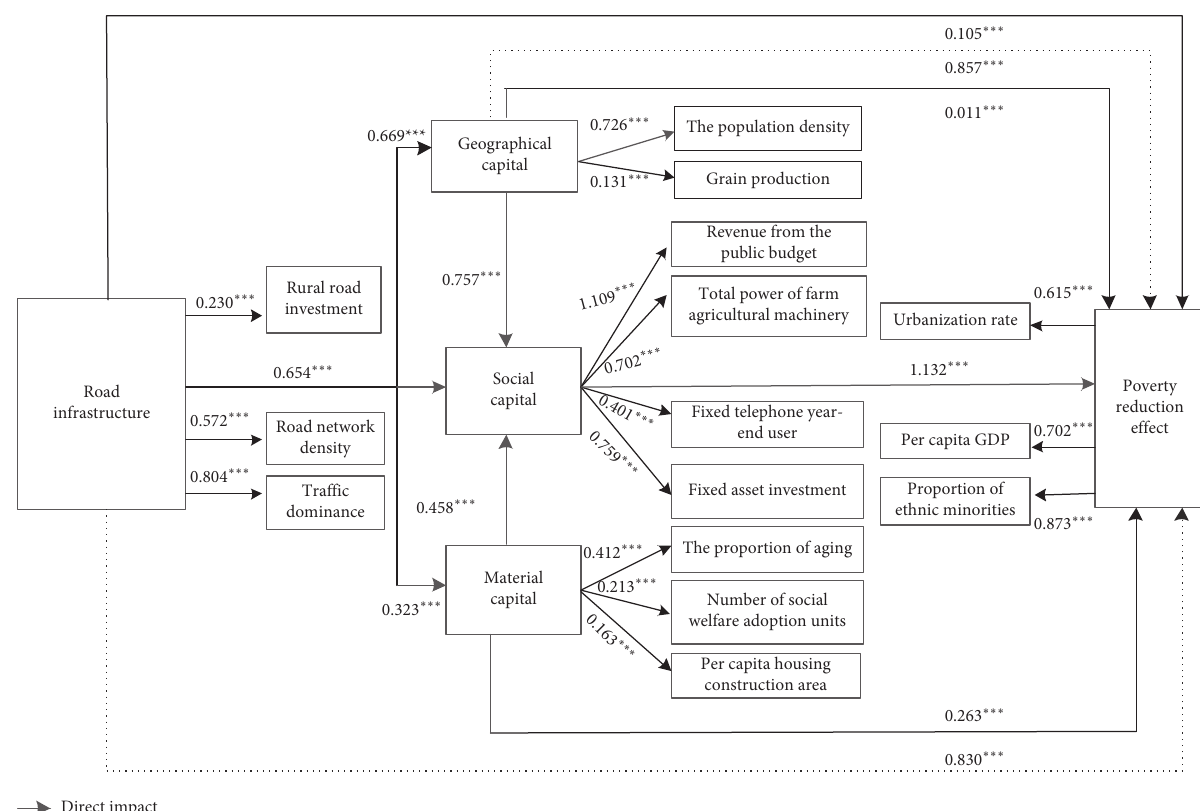
Figure 6: Estimation results of the SEM for poverty alleviation path of road